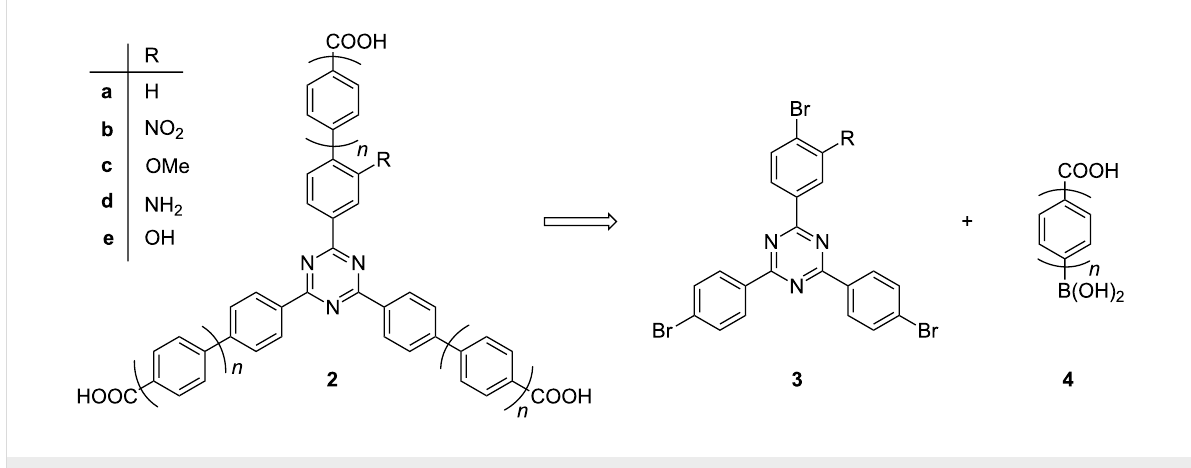
Figure 3: Retrosynthetic analysis for extended TATBs 2 : triple Suzuki coupling between tribromotriazines 3 and boronic acids 4 .